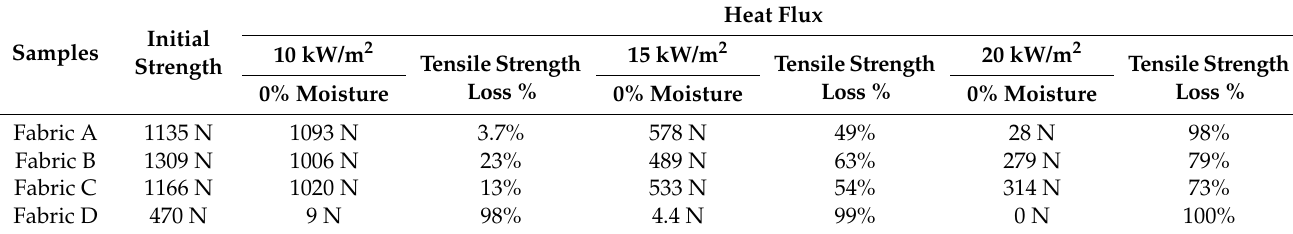
Table 3. Effect of radiant heat on tensile strength (Dry condition).